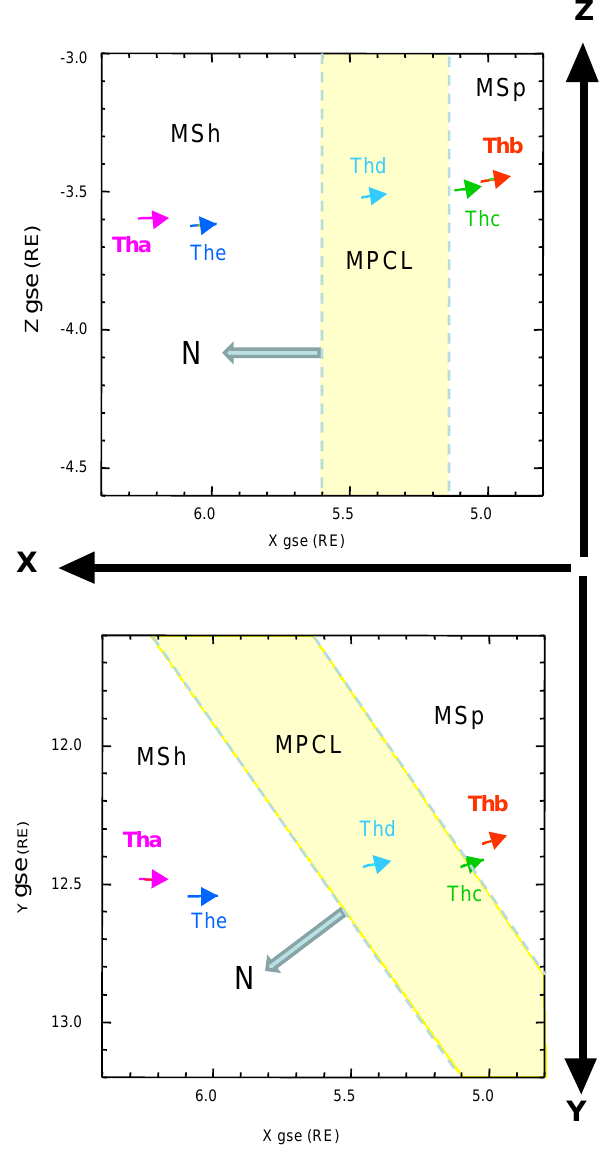
Fig. 1. Positions of the 5 THEMIS spacecraft in XZ (top) and XY (below) GSE coordinates, as indicated by colored arrows. Notice that the Y and Z coordinates are about the same for all the space- craft. Their locations are spread along the X direction. Dotted lines suggest possible boundaries of the MpCL and illustrates the brack- eting of the MpCL. The XZ plane is a cut for y ≈ 12 . 5 R E (corre- sponding to the locations of the spacecraft). Given the size of the region displayed, no attempt wase made to take field lines curvature into